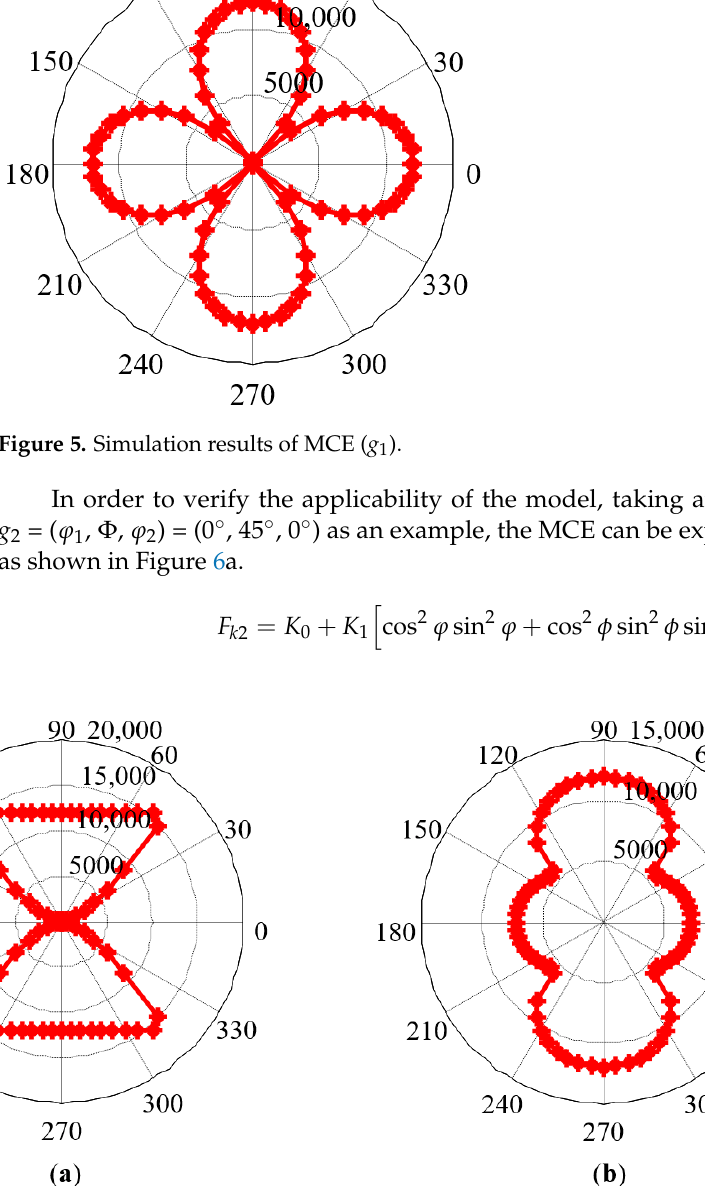
Figure 6. Simulation results of MCE: ( a ) grain orientation g 2 ; ( b ) grain orientation 60% g 1 + 40% g 2 . Even in strong texture materials such as oriented silicon steel, there is more than one grain orientation. It is assumed that 60% and 40% of grains are, respectively, in the orientation g 1 and orientation g 2 inside the material. By solving the weighted average of the MCE of each grain, the MCE of the polycrystal can be obtained (Figure 6b).